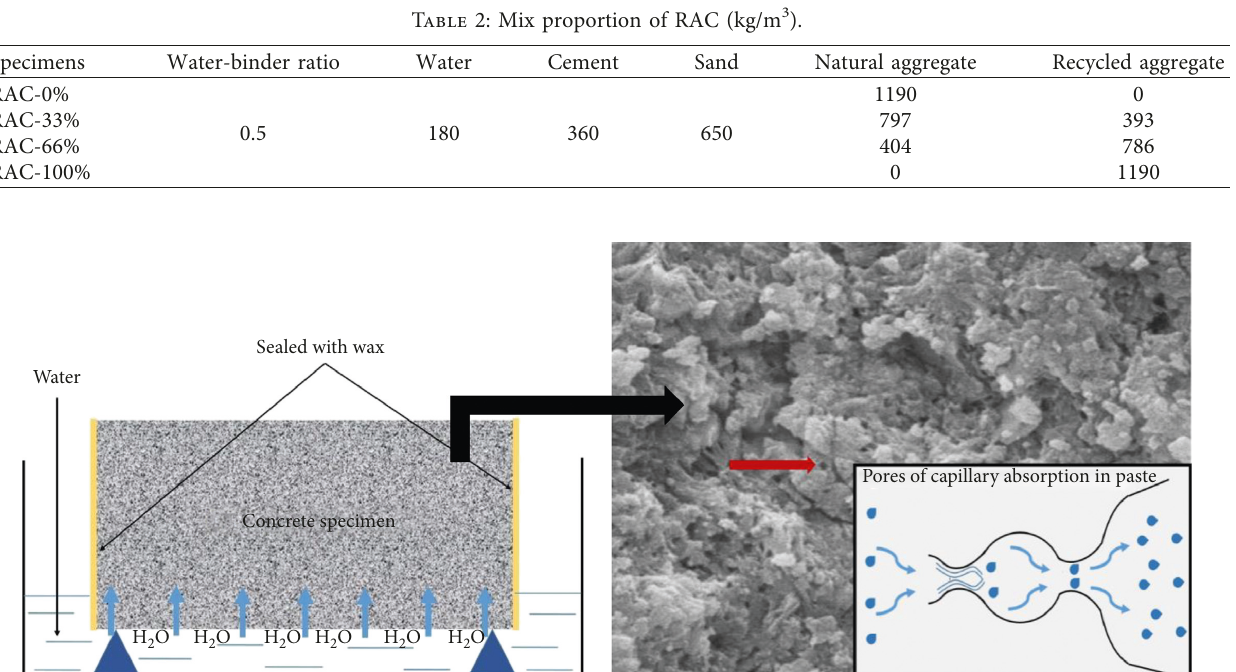
Figure 1: Capillary absorption